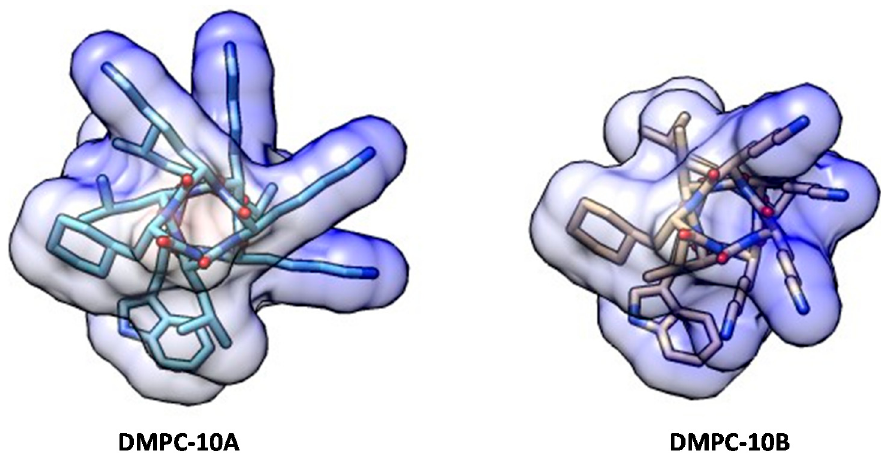
Figure 2. The conformation of DMPC-10A and DMPC-10B simulated by molecular modeling. Both peptides were represented as a helical structure. The coulombic surface of each peptide was applied to display the positively charged residues (blue area).